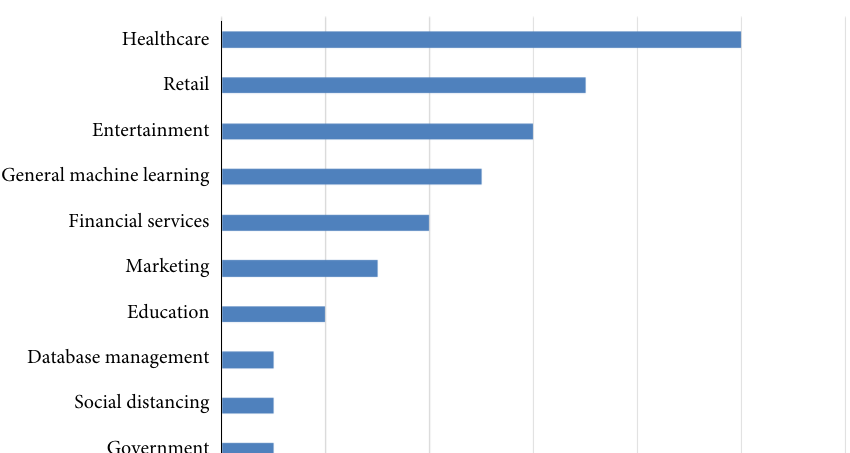
Fig. 4 Participants ’ ethical AI prioritisation.